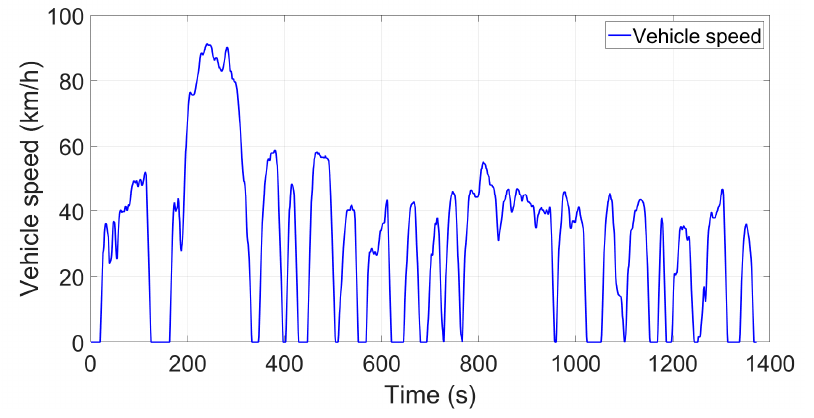
Figure 7. FTP-72 driving cycle.